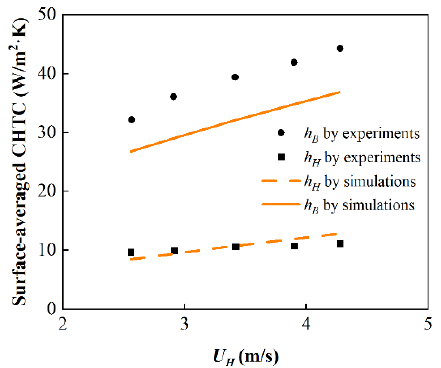
Figure 6. Comparison of wind velocity profile between experiments and simulations ( B = 0.035 H , W = 0.05 H , θ = 45°, φ = 0°, U H = 3.4 m/s).